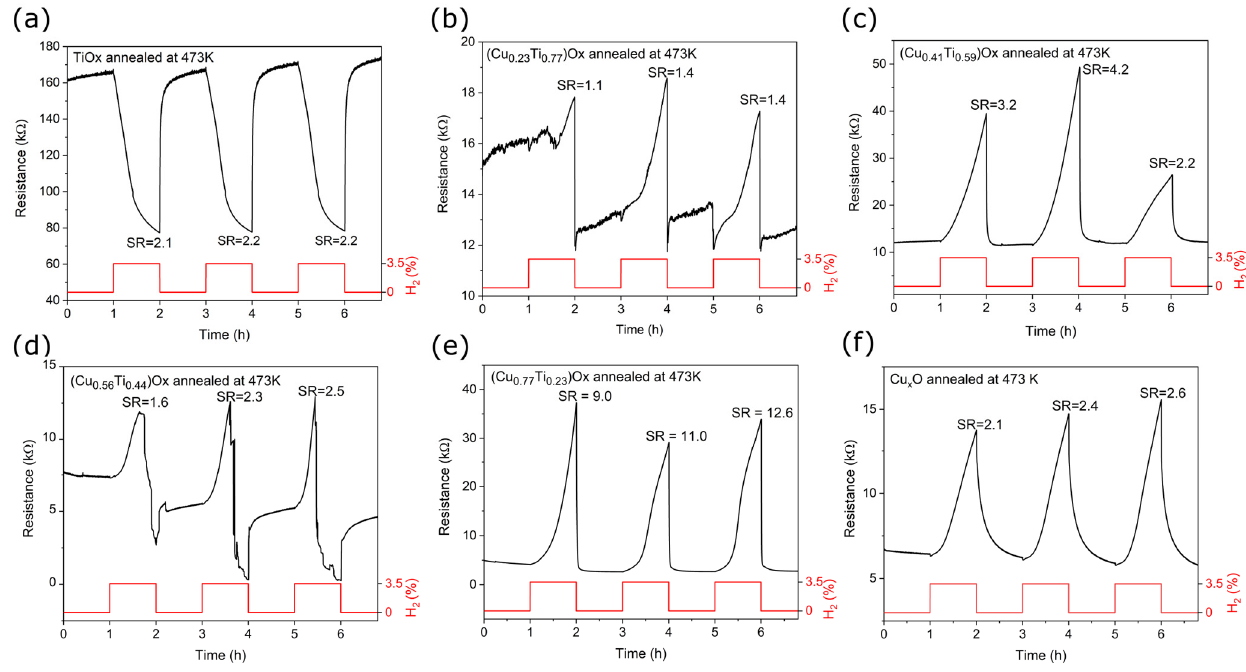
Figure 9. Resistance changes of: ( a ) TiO x , ( b – e ) (CuTi)Ox, and ( f ) Cu x O thin films annealed at 473 K upon exposure to 3.5% H 2 .